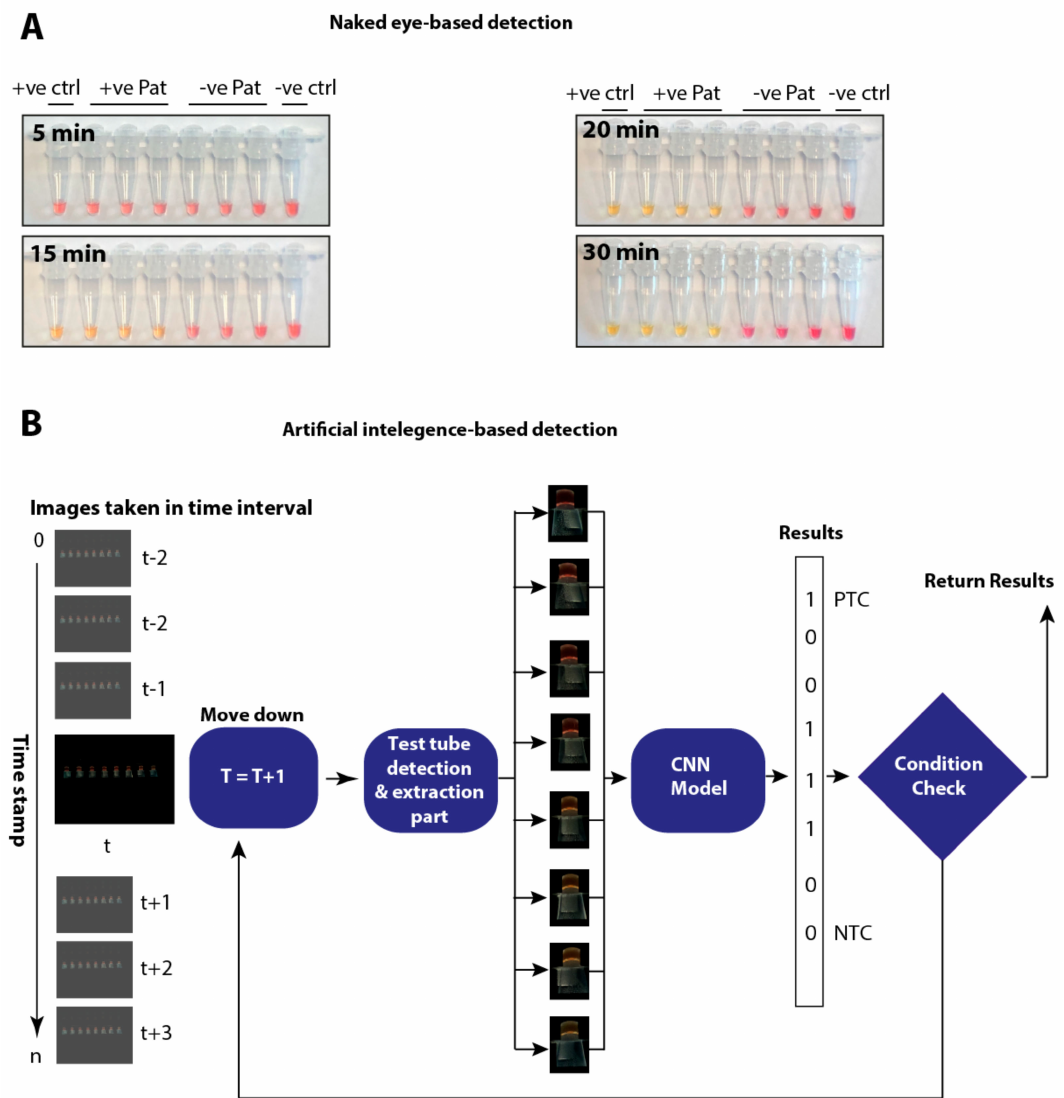
Figure 5. Conventional and AI-assisted interpretation of LAMP results. ( A ) Temporal analysis of known positive and negative patient samples from 360 images taken from RPi for visual interpretation of LAMP results. ( B ) Interpretation of corresponding patient samples by the AI-assisted LAMP